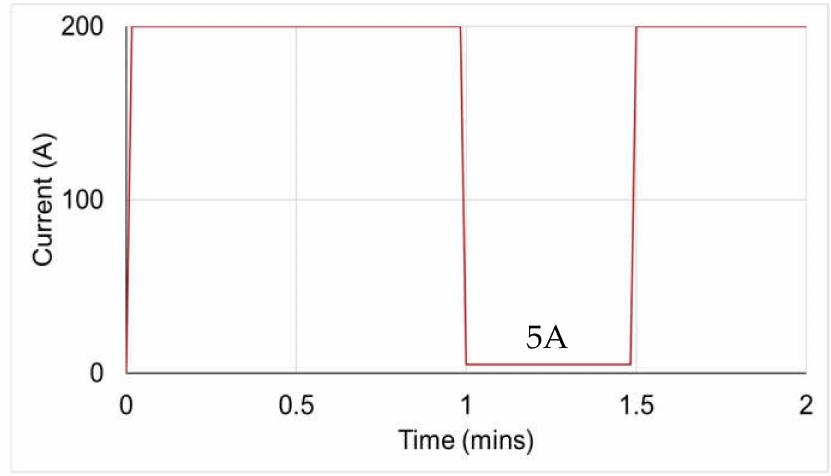
Figure 16. Demand-side response applied to EV